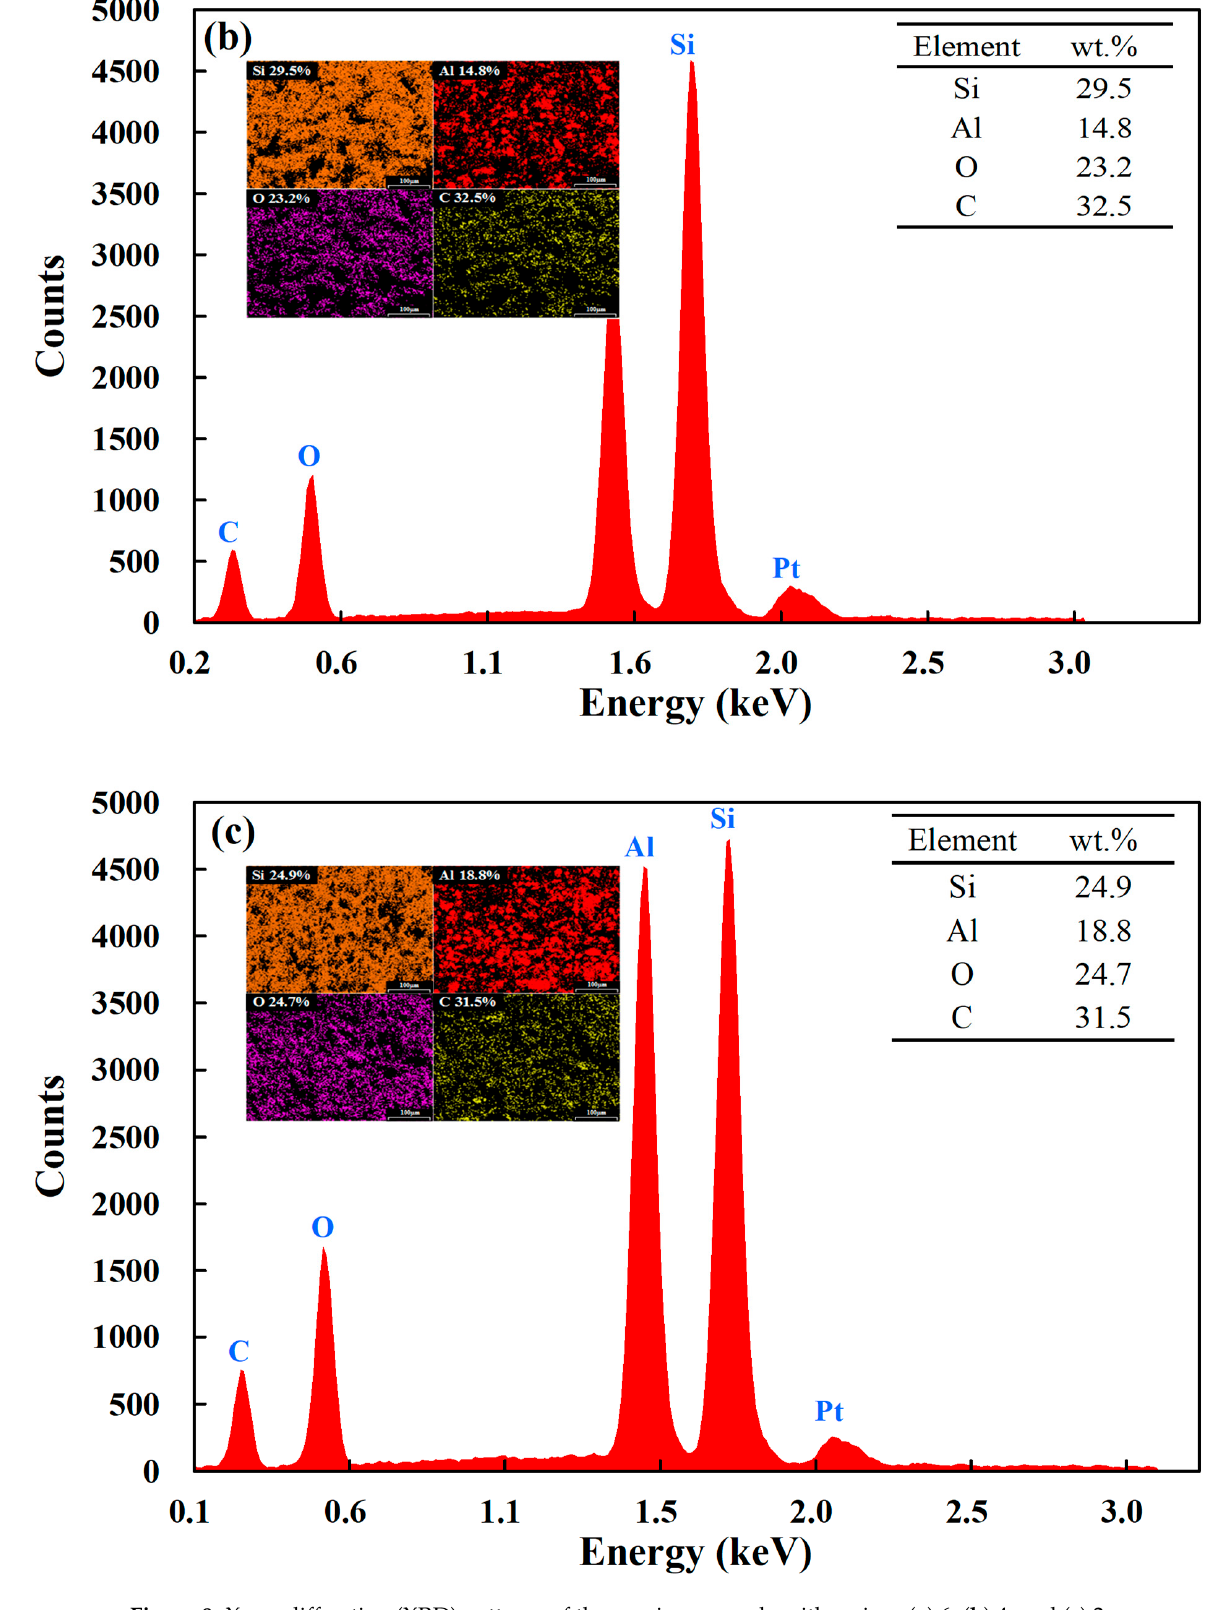
Figure 8. X-ray diffraction (XRD) patterns of the specimens made with recipes ( a ) 6, ( b ) 4, and ( c ) 2.